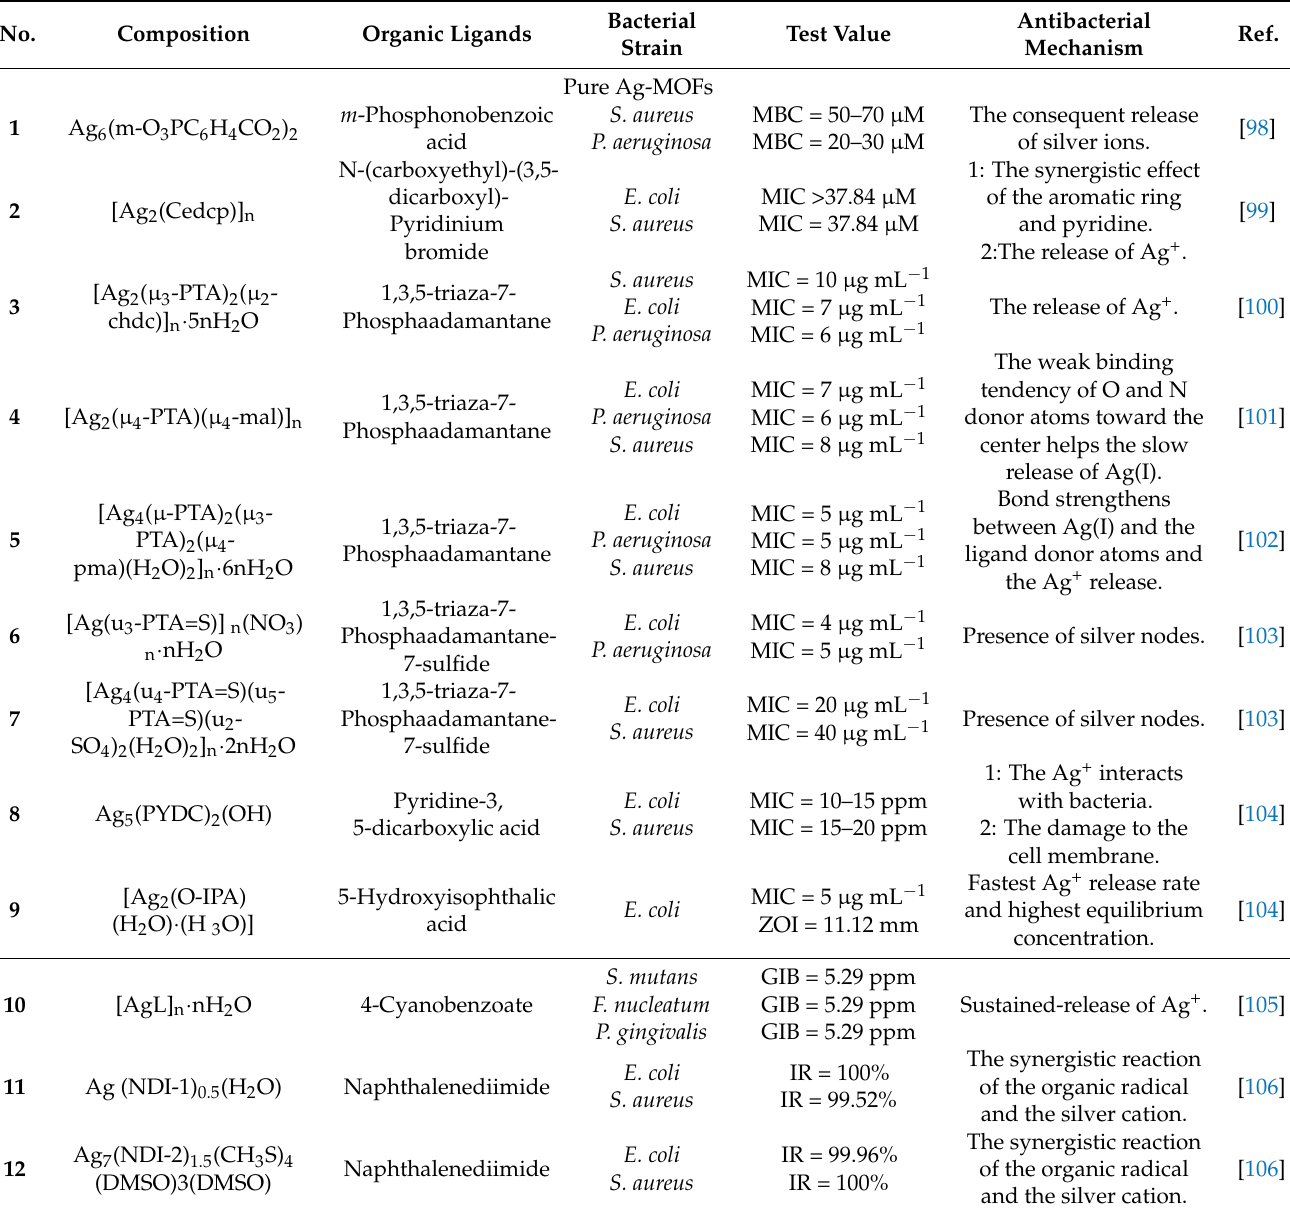
Table 1. Antibacterial silver-based MOFs and their composition on the bacterial strain and antibacte- rial